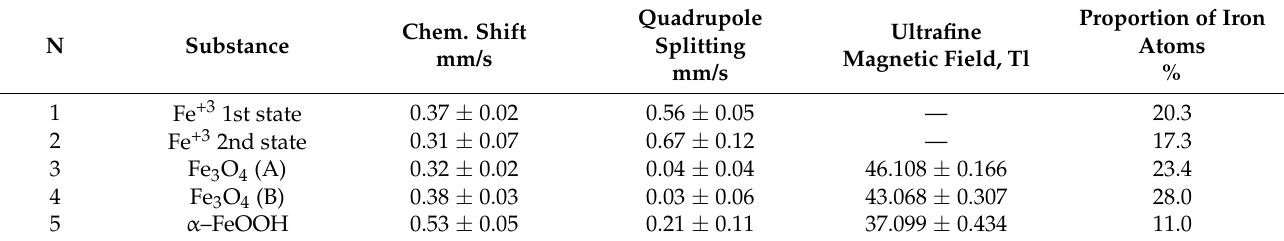
Table 1. Results of processing MLPSICG Mössbauer